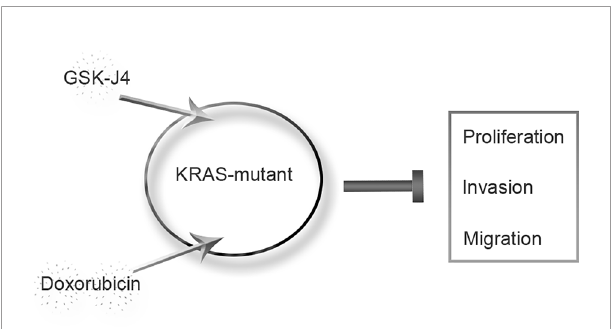
FIGURE 5 | Proposed model of KRAS-mutant anaplastic thyroid cancer with GSK-J4 and doxorubicin